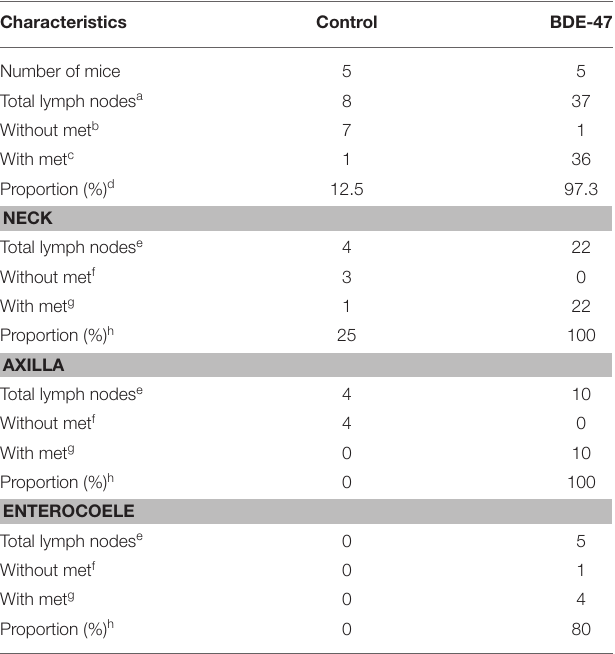
TABLE 1 | Summary of the numbers of lymph nodes with or without metastatic tumors by Cytokeratin IHC staining. Characteristics